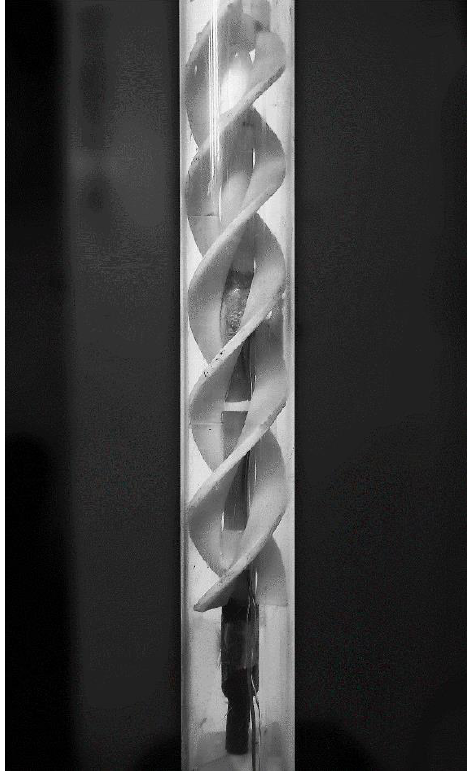
Figure 10. Helical baffle with concentric heater .